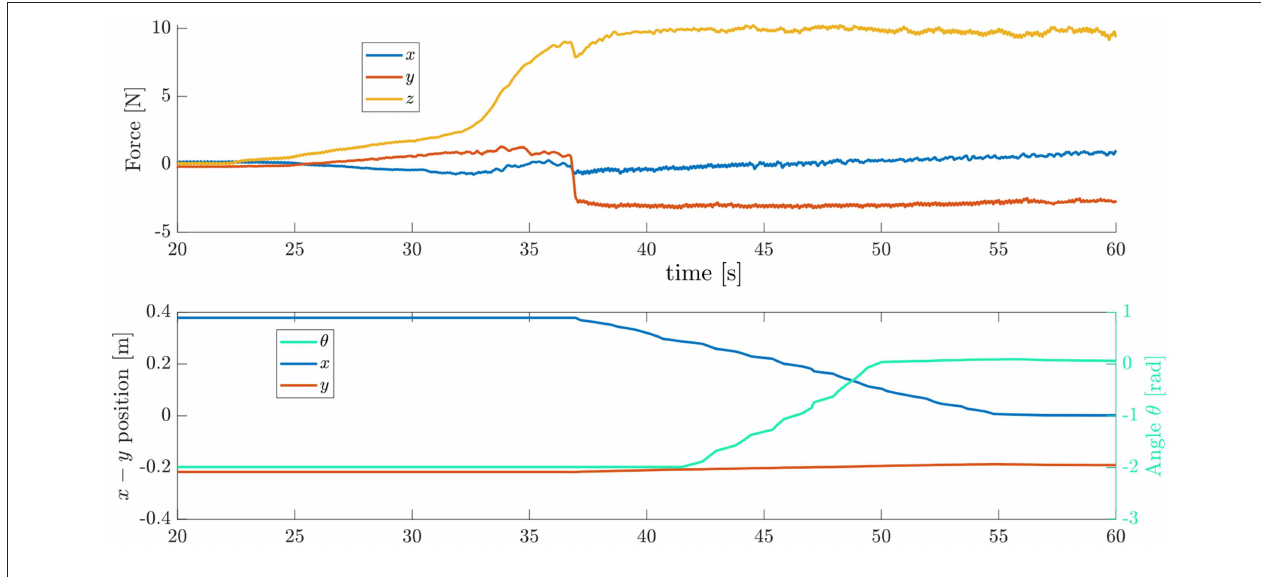
FIGURE 3 | Strategy 1 Continuous Slide and Grasp–contact forces and object trajectory.